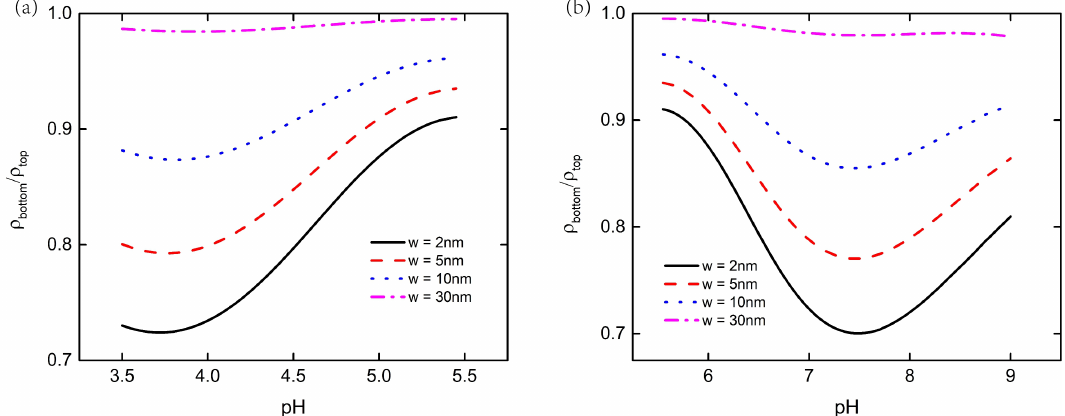
Figure 4. The ratio of bulk charge density of PE brush layer at the bottom and the top of particle as a function of pH under di ff erent distances between the particle and the plate at C KCl = 1 mM. ( a ) At pH < 5.5, the charge of PE brush layer is positive ( b ) at pH > 5.5, the charge of PE brush layer is